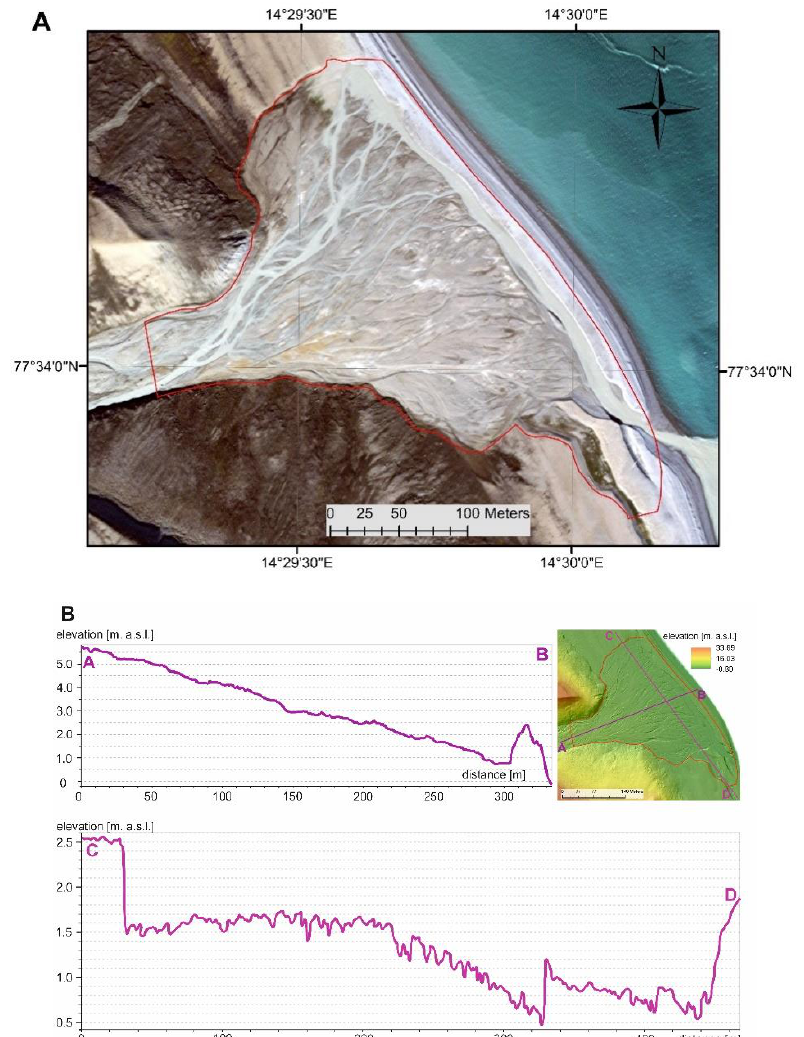
Figure 1. ( A ) Location of the study area. The mouth section of the gravel-cobble Scott River valley floor (north-west part of the Wedel Jarlsberg Land, south-west Svalbard). Red line: area of interest (AoI). Source of satellite image in the background: Image Landsat/Copernicus, Image IBACO; ESRI, DigitalGlobe, GeoEye, Earthstar Geographics, CNES/Airbus DS, USDA, USGS, AeroGRID, IGN and the GIS User Community. ( B ) The elevation of the Area of Interest: A–B longitudinal profile; C–D cross-profile.